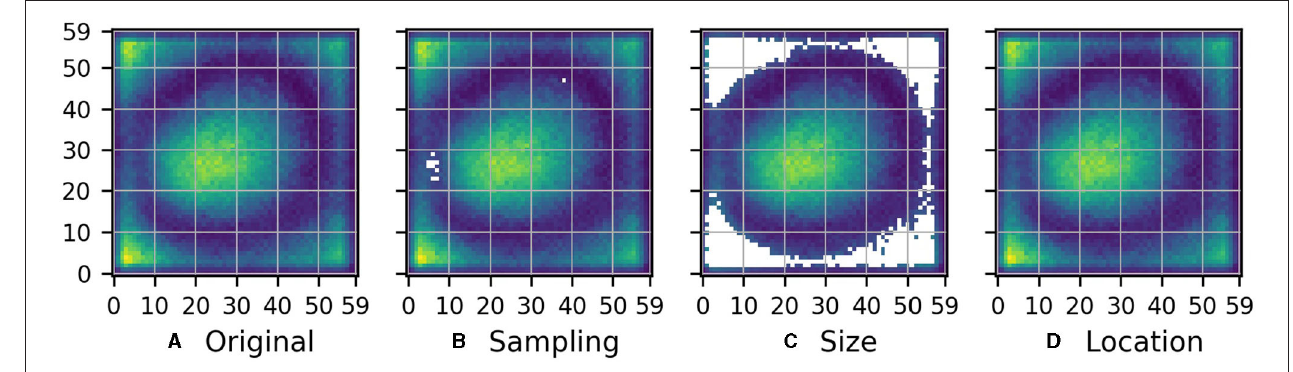
FIGURE 3 | (A) Description E d of the function that CNN1 learned when it was trained on the original rain prediction task (see Figure 1A ). The description is a measure of the average importance of each pixel in the 60 × 60 pixels input region for the predictions of the model. Yellow color indicates high and blue color low importance. (B–D) As (A) , but pixels for which the relative distance between the original description E d and one of the variant descriptions E d v i obtained for the sampling, size, and location variant tasks, respectively, exceeds the threshold of t = 0.5, are